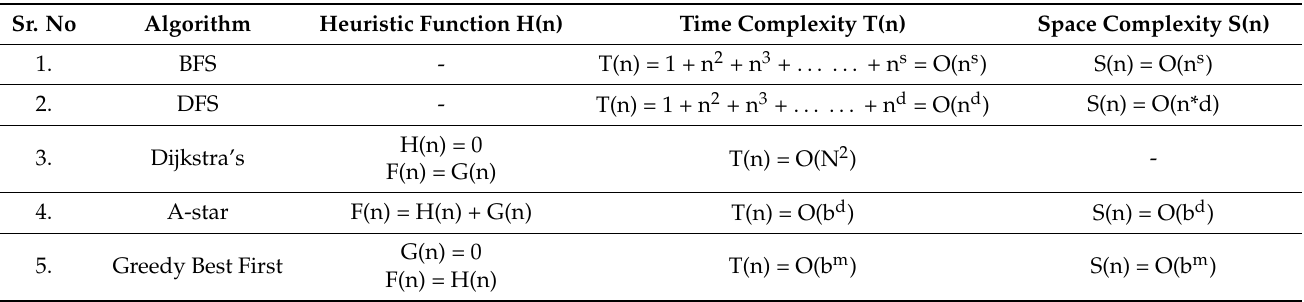
Table 2. Heuristic function, time and space complexities of pathfinding